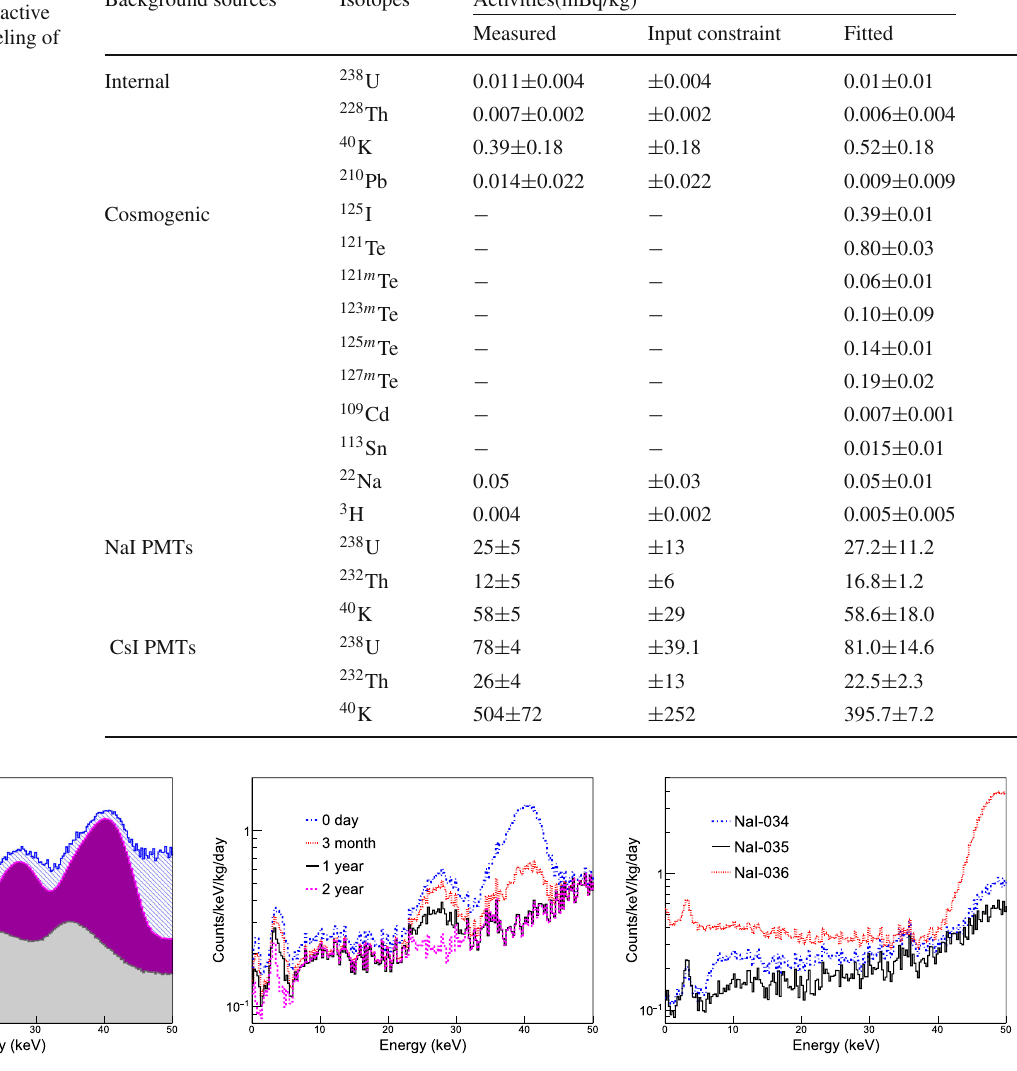
Table 4 Summary of the measured and fitted radioactive contaminants in the modeling of the NaI-035 crystal